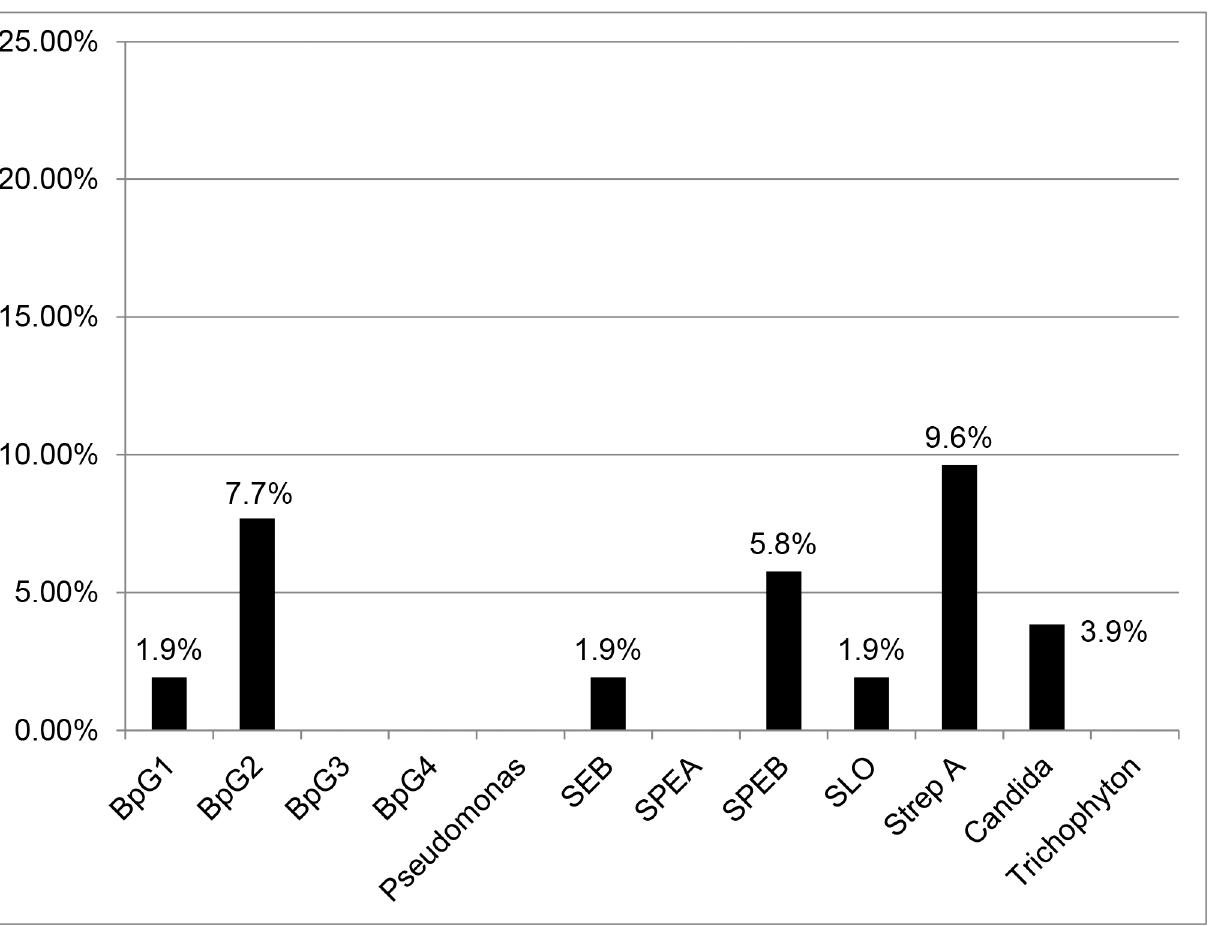
Fig 2. Proportion of ADL episodes with an antibody response for filarial, bacterial, and fungal antigens among a cohort of 52 paired serum samples from patients enrolled in a lymphedema program in Léogâne, Haiti. Filarial antigens: BpG1, BpG2, BpG3, and BpG4. Bacterial antigens: Pseudomonas , SEB, SPEA, SPEB, SLO, and Strep A. Fungal antigens: Candida and Trichophyton. All antibody change levels represent a 100 percent (two- fold) increase in antibody titer from the ADL to convalescent time